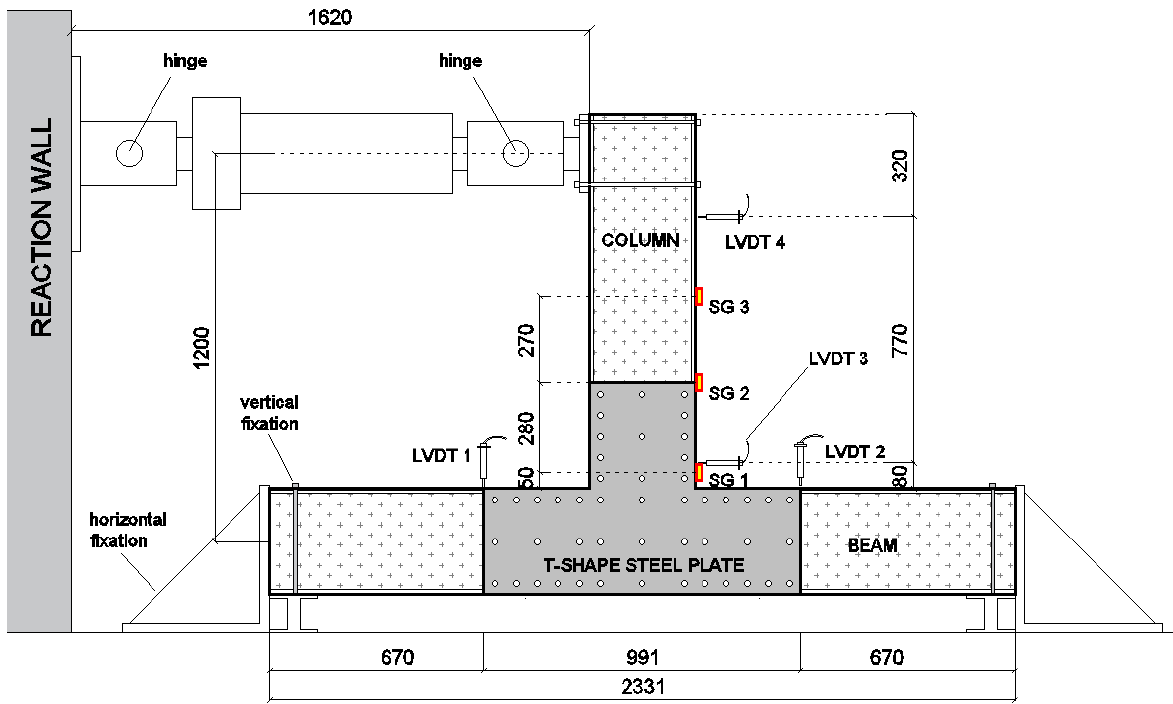
Figure 5. Test set ‐ up of beam ‐ to ‐ column element (specimens T1 and T2_W) (measures in